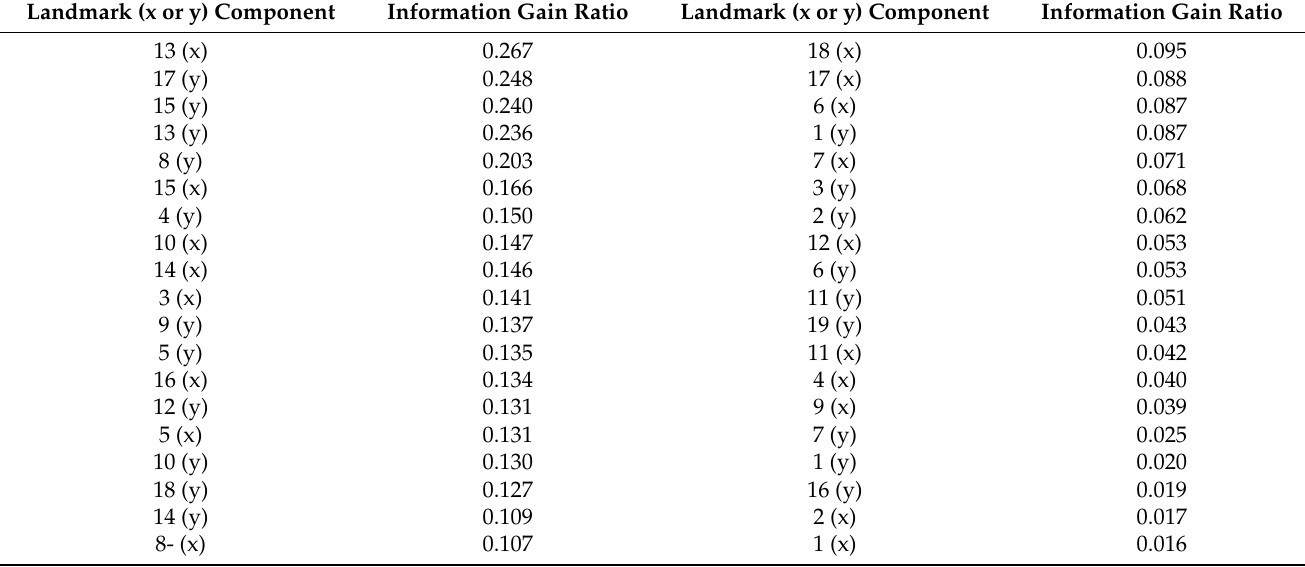
Table 4. Input feature regarding the 19 landmarks (x, y) coordinates ranked by information